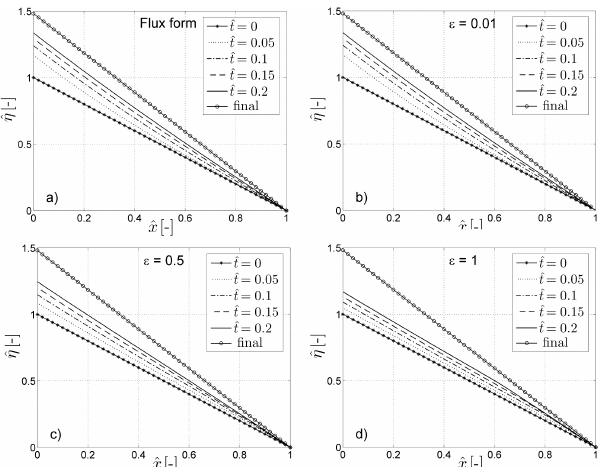
Figure 2. Bed profile evolution for the case ˆ E f = 2: (a) flux form; (b) entrainment form for ε = ¯ r / L d = 0 . 01, (c) entrainment form for ε = 0 . 5 and (d) entrainment form for ε = 1, using the thin-tailed ex- ponential step length function of Eq. (8). As ε increases, it is clearly seen that the di ff erences between the results for the two formula- tions increases. More specifically, as ε increases, nonlocality ef- fects mediate a transition from upward concave transient profiles to downward concave transient profiles.